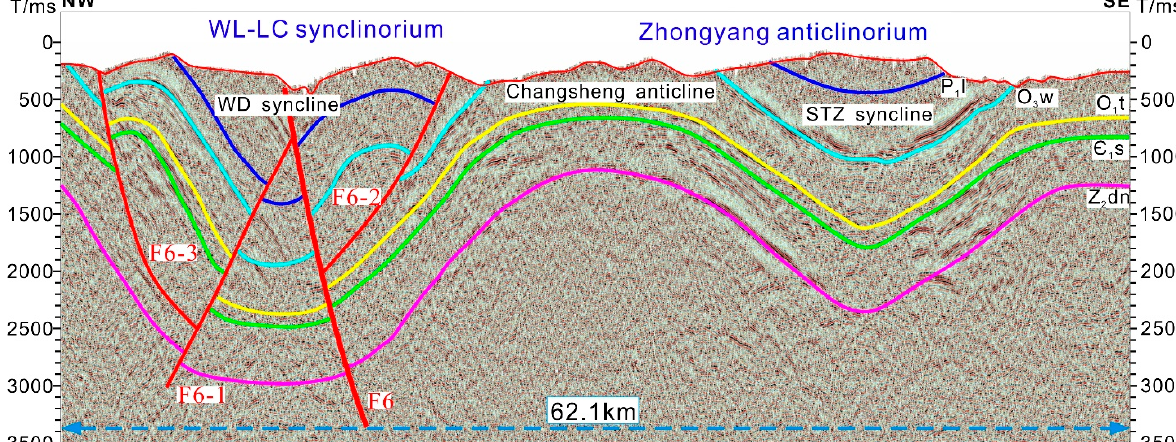
Figure 5. Seismic interpretation profile of L2. (F6: Pengshui–Jianshin fault).